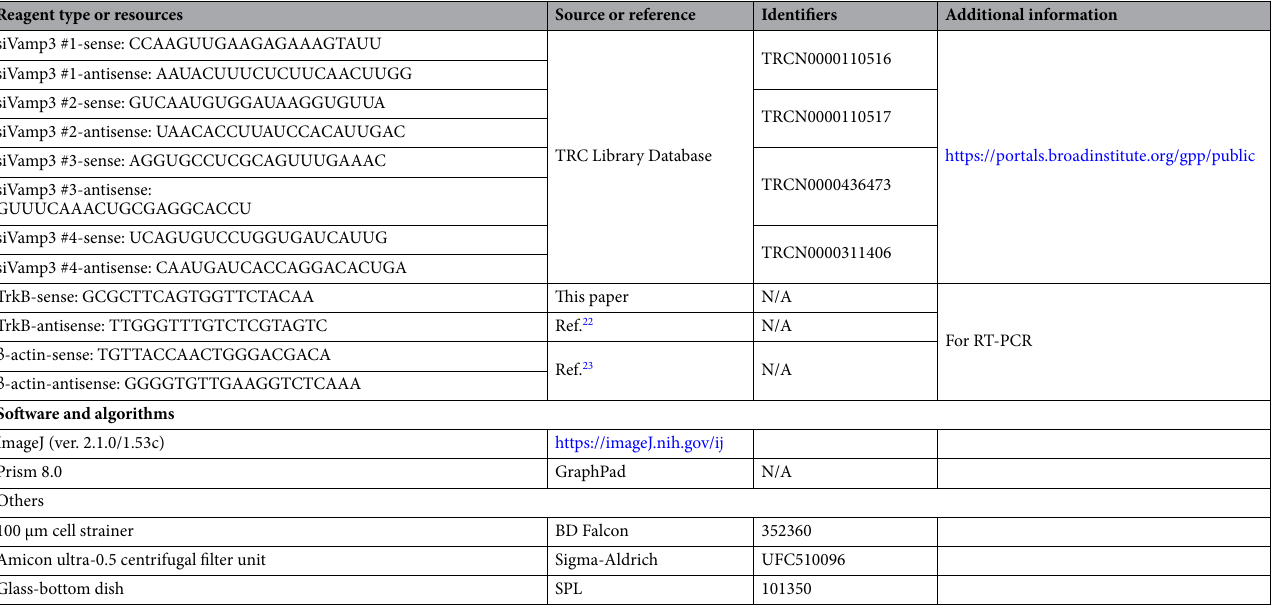
Table 1. Key resource table. HRP horseradish peroxidase, mAB monoclonal antibody, HBSS Hank’s balanced salt solution, DMEM Dulbecco’s modified eagle medium, HBEGF heparin binding EGF like growth